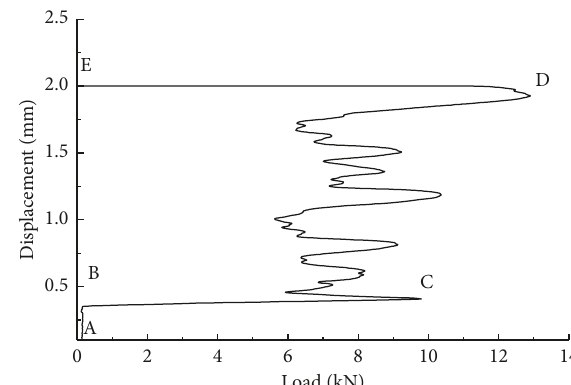
Figure 9: The influence of pressure-temperature coupling on block